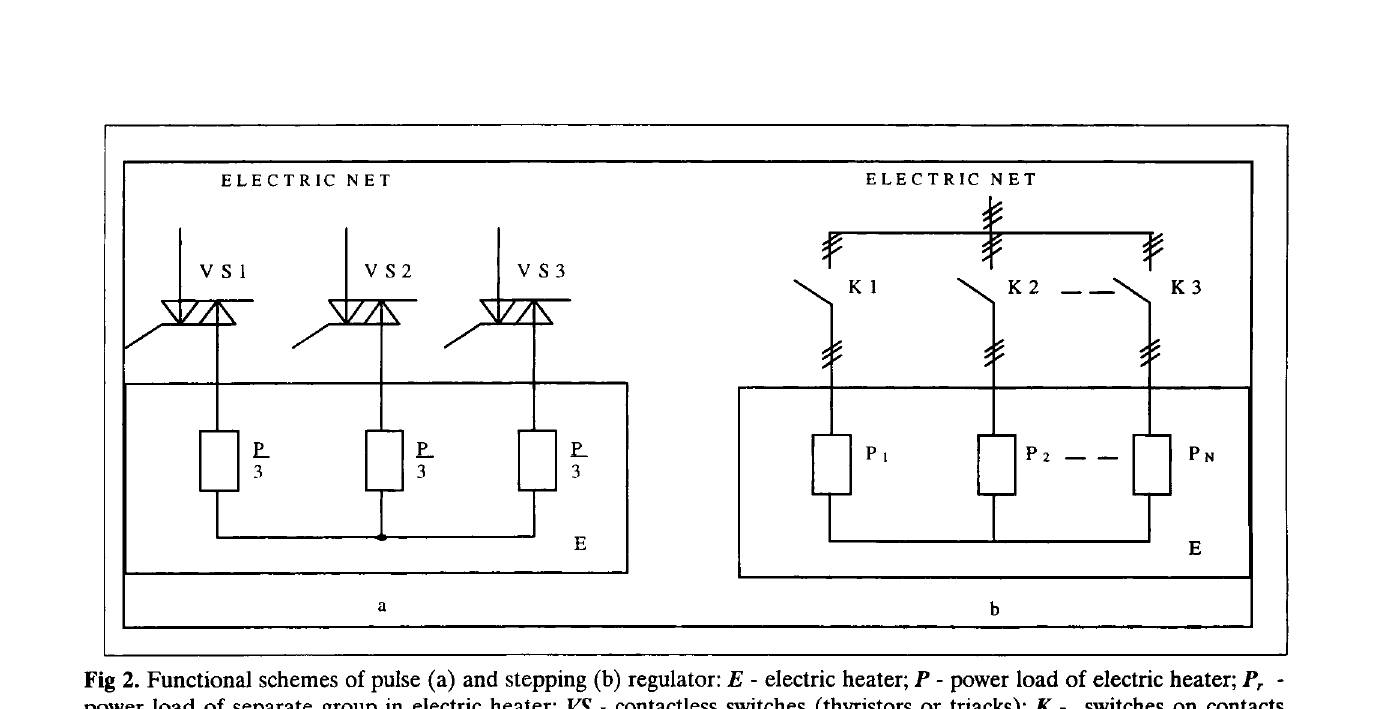
Fig 2. Functional schemes of pulse (a) and stepping (b) regulator: E- electric heater; P- power load of electric heater; P, - power load of separate group in electric heater; VS - contactless switches (thyristors or triacks); K - switches on contacts ( contactors).